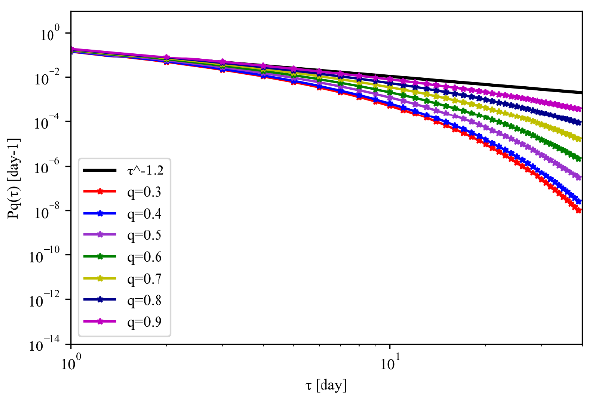
Figure 5. Probability density functions τ of precipitation events with sandpile model theory in different thresholds (Beijing Station).